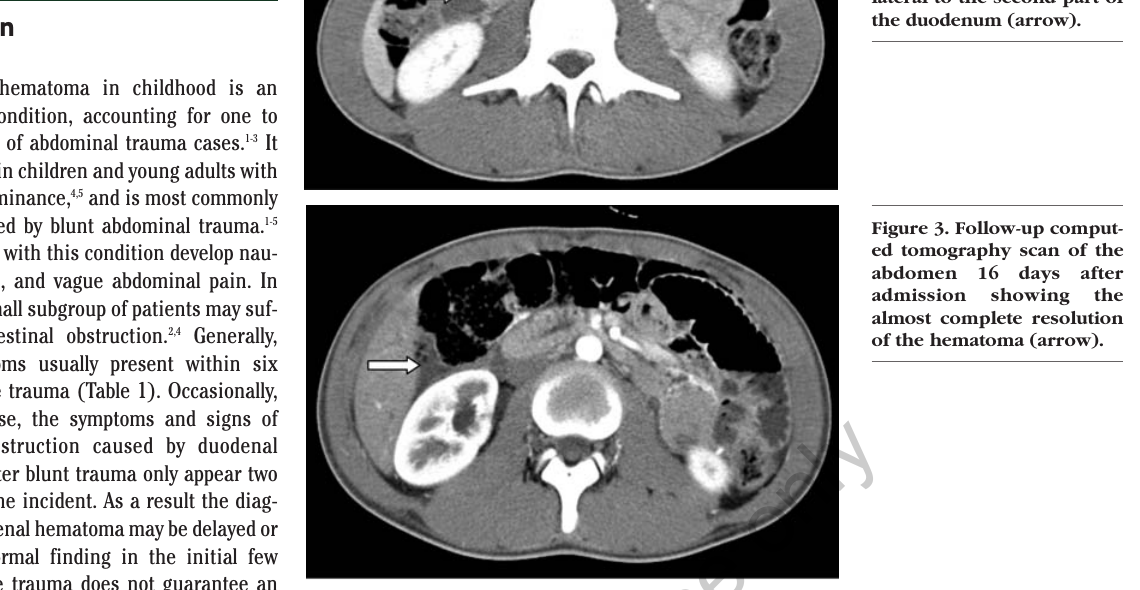
Figure 2. Computed tomog- raphy scan of the abdomen immediately after admis- sion showing a hematoma lateral to the second part of the duodenum (arrow).